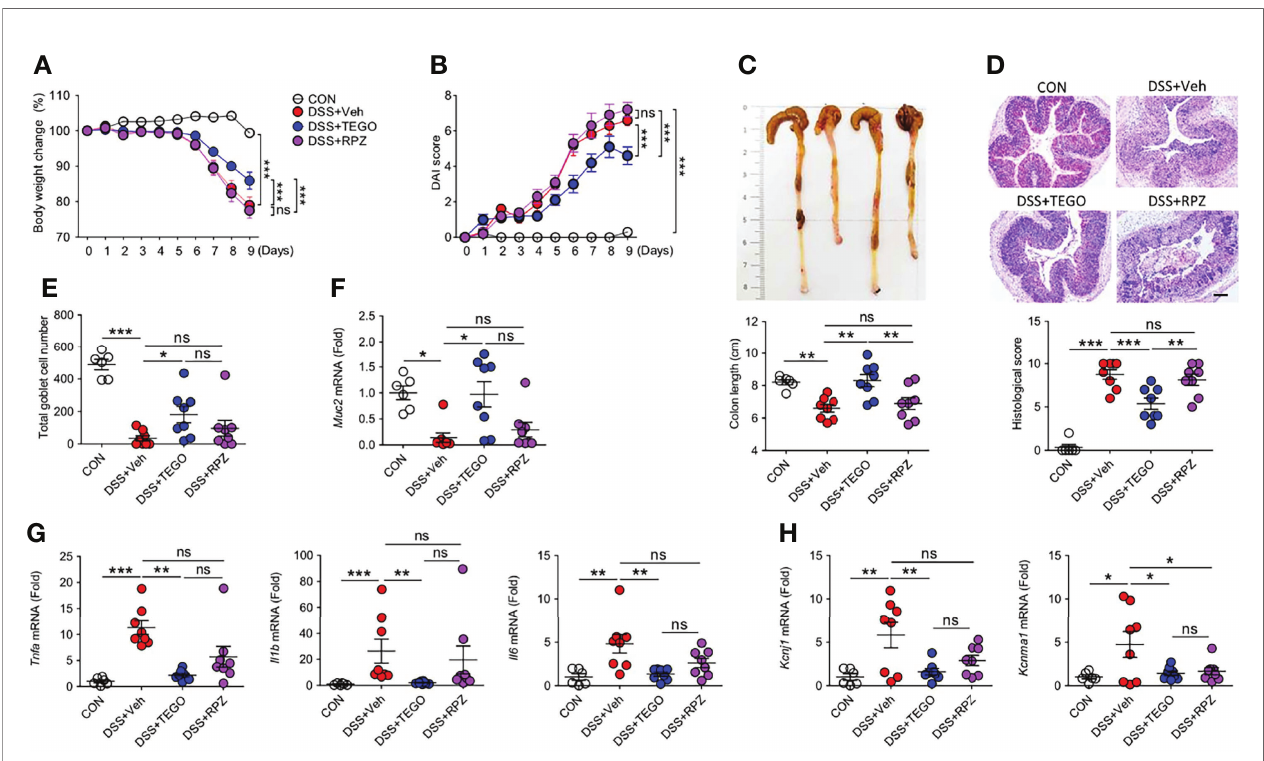
FIGURE 2 | Tegoprazan ameliorates colon damage in DSS-induced colitis. Colitis was induced in 8-week-old male mice by administering 2% DSS in distilled drinking water for 5 days, followed by normal drinking water for 4 days. Tegoprazan (30 mg/kg) and rabeprazole (30 mg/kg) were administered orally twice daily throughout the experiment. All drugs were dissolved in 0.5% (w/v) methylcellulose. After sacri fi cing animals on Day 9, the entire colon from anesthetized mice was harvested for further investigations. The detailed methods are described in the Materials and Methods section. (A) Body weight change. (B) Disease activity index (DAI). (C) Colon lengths and representative images. (D) Representative image following periodic acid-Schiff (PAS)-staining and histological score. Scale bars = 200 m m. (E) Total goblet cell number. (F) Gene expression level of mucin ( Muc2 ). (G) Gene expression level of proin fl ammatory cytokines ( Tnfa , Il1b , and Il6 ). (H) Gene expression level of secretory K + channel genes ( Kcnj1 and Kcnma1 ). Data represent the mean of triplicate real-time quantitative RT-PCR. Data represent the mean ± standard error of the mean (S.E.M): For (A – E) CON (n = 6), DSS+Veh, DSS+TEGO, and DSS+RPZ (each n = 8). For (F, G) CON (n = 6), DNBS+Veh (n = 4), DNBS+TEGO (n = 6), and DNBS+RPZ (n = 6). Signi fi cance is indicated by * p < 0.05, ** p < 0.01, and *** p < 0.001 using two-way ANOVA followed by Bonferroni post hoc test (A, B) or one-way ANOVA followed by Dunnett ’ s multiple comparison test (C – H) . ns, not signi fi cant; CON, normal control; DSS, treated with dextran sulfate sodium; Veh, treated with vehicle; TEGO, treated with tegoprazan; RPZ, treated with